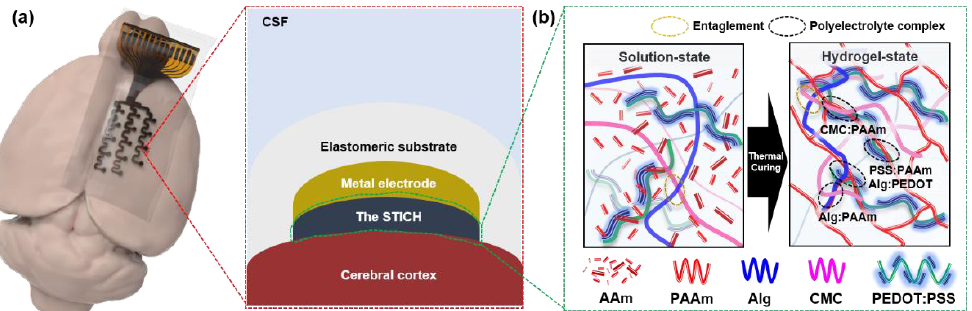
Figure 1. Illustrations of the stretchable surface electrode arrays using the soft tough ionic conductive hydrogel (STICH) for adaptive conformal brain interfacing. ( a ) In vivo demonstration of ECoG monitoring using an animal model, in which the electrode device is mounted on the cerebral cortex of a rat (left). The STICH layer coated on the metal electrode channel provides adaptive brain- electronics interfacing owing to its soft modulus and conformal contact with the cortex (right). ( b ) Three types of gel networks: intertwined, joined via covalent bonding (black ovals), and showing entanglements (yellow ovals) between the amine groups on polyacrylamide chains and the carboxyl groups on the Alg and CMC chains. (acrylamide, AAm; alginate, Alg; carboxymethyl cellulose, CMC; polyacrylamide, PAAm; poly(3,4 − ethylenedioxythiophene):poly(styrenesulfonate), PE- DOT:PSS).